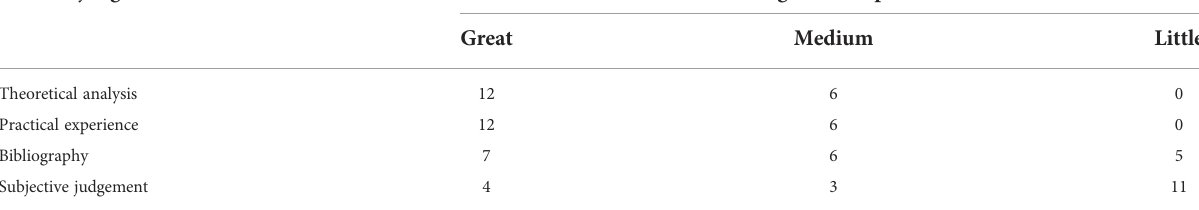
TABLE 3 Analysis of the basis of judgement of the 18